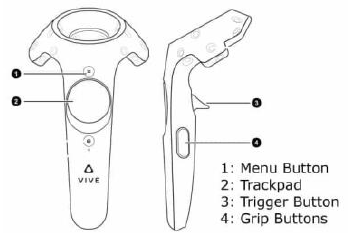
Figure 7: HTC Vive Pro controllers (Source: